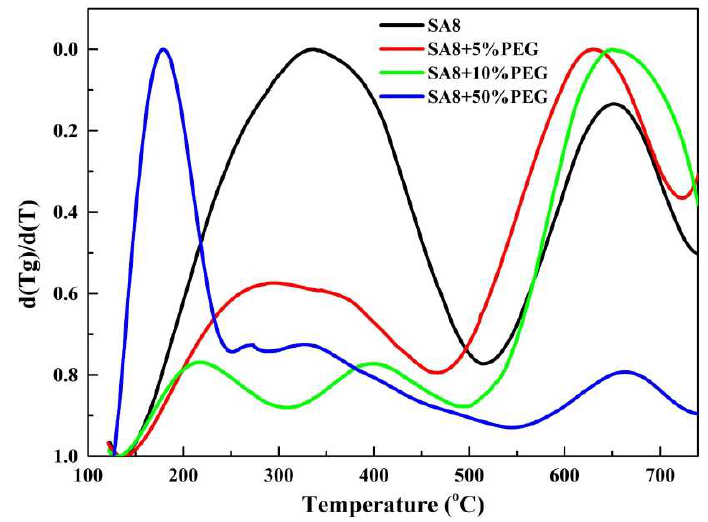
Figure 12. DTG diagram of SA8 polymer blended with PEG.